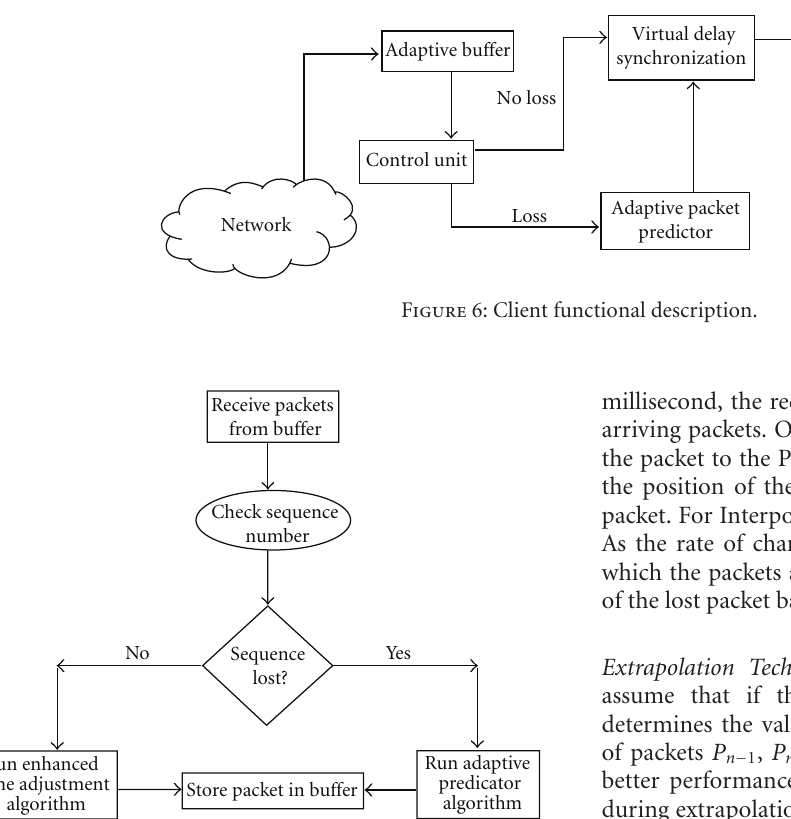
Figure 7: Control unit flow chart.